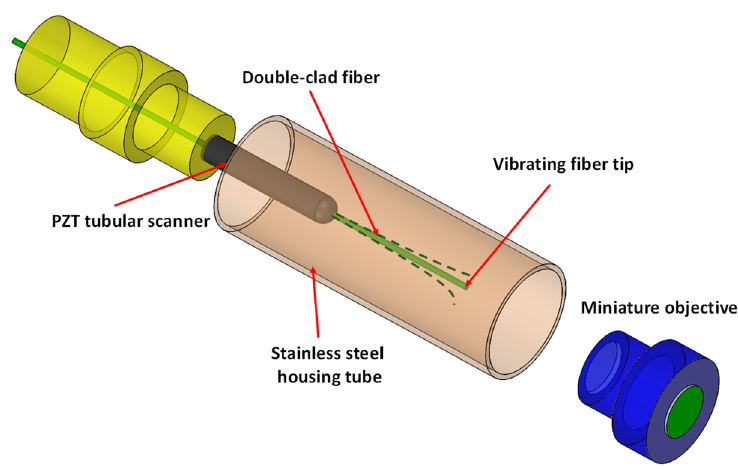
Figure 10. Schematic of the assembly of a fiber scanning system for a two-photon microscope with double-clad fiber actuated by a PZT tubular scanner [70].